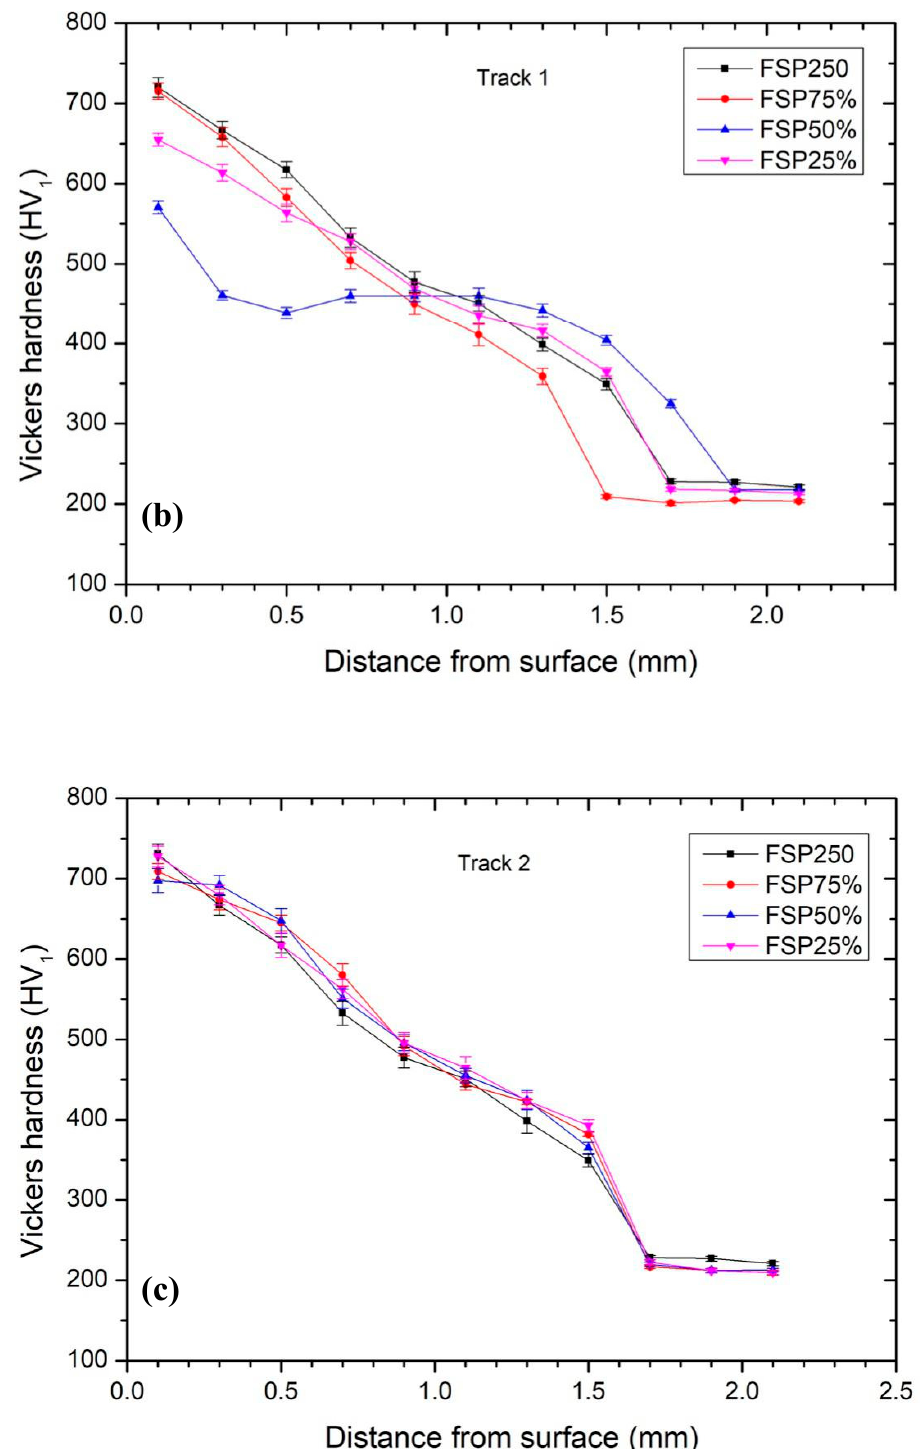
Figure 8. ( a ) Illustration showing the overlapping of track 1 and track 2; the hardness profiles of FSPed specimens along the centerline of ( b ) track 1 (C1) and ( c ) track 2 (C2).